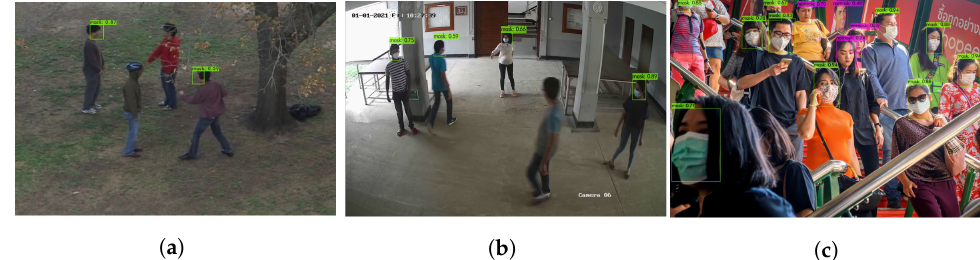
Figure 9. Mask detection detection examples. ( a ) UTI dataset; ( b ) UOP dataset; ( c ) Moxa3K